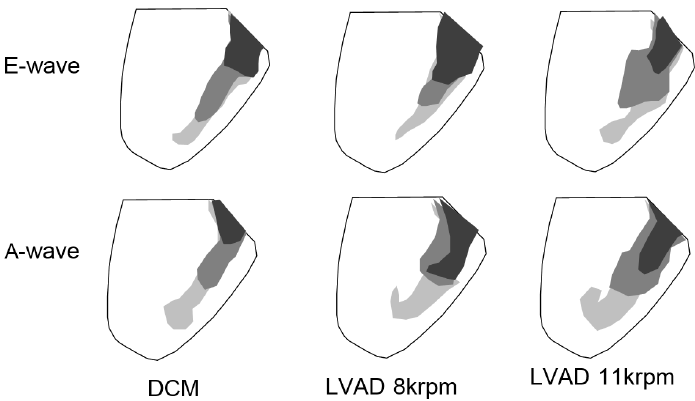
Figure 4. LCS ridges extracted from the reverse FTLE illustrate the effect of the LVAD on LV filling dynamics.